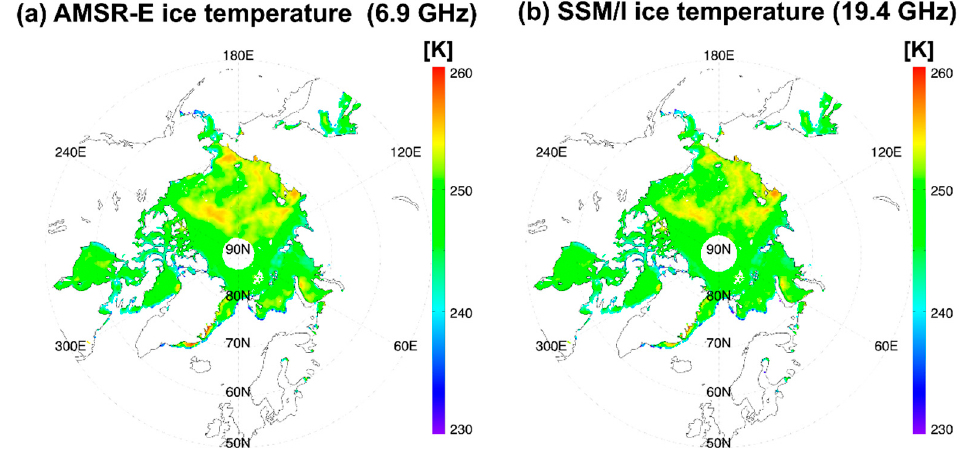
Figure 5. Geographical distributions of the ( a ) AMSR-E 6.9 GHz and ( b ) SSM/I 19.4 GHz-retrieved sea ice temperature for 1 January 2004.